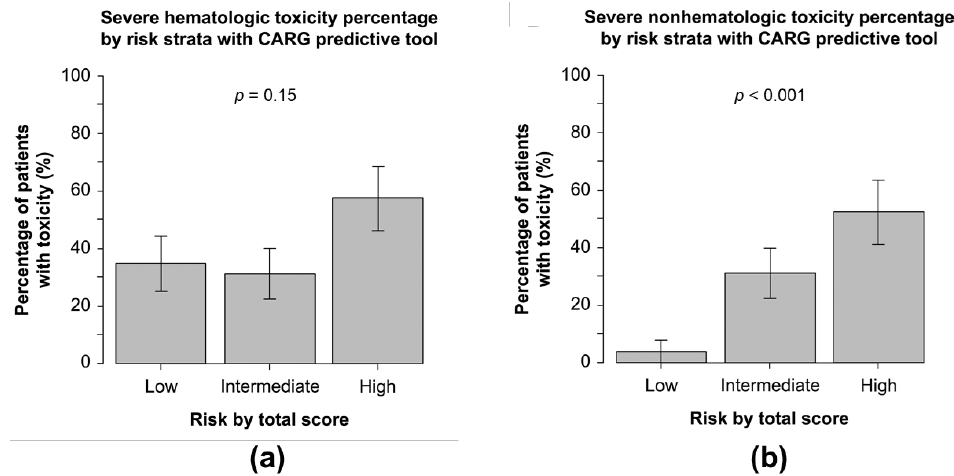
Figure 2. The percentage of participants with severe hematologic ( a ) and non-hematologic ( b ) toxicity based on CARG predictive tool risk strata. Abbreviations: CARG, Cancer and Aging Research Group.